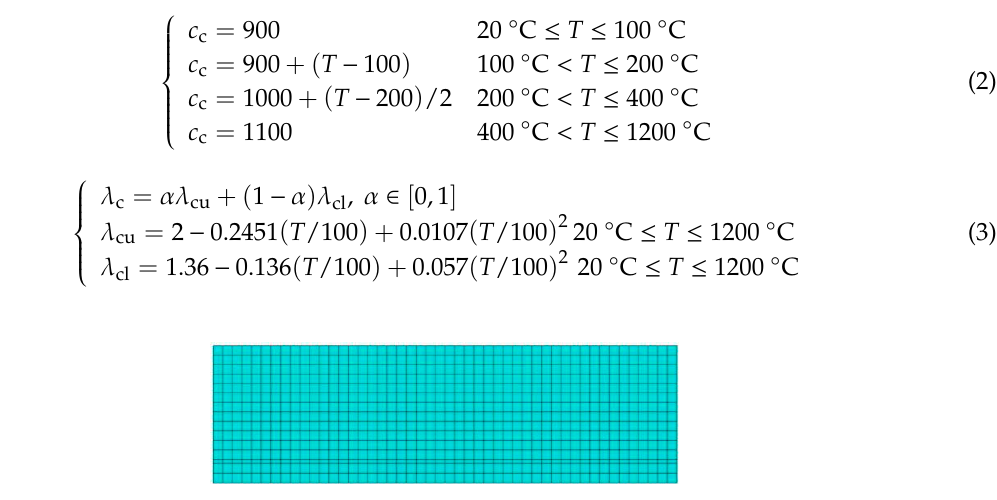
Figure 9. Meshes on Section 2-2.